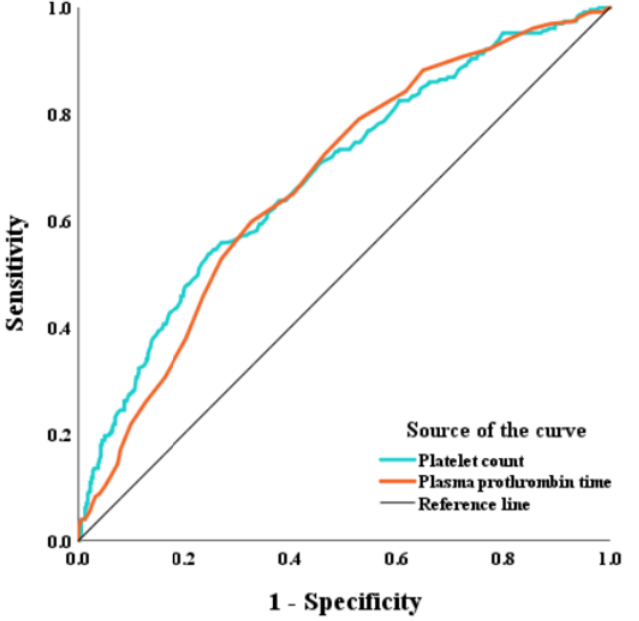
Figure 4. Receiver-operating characteristic curves of PC and PT for the diagnosis of adenomyosis.